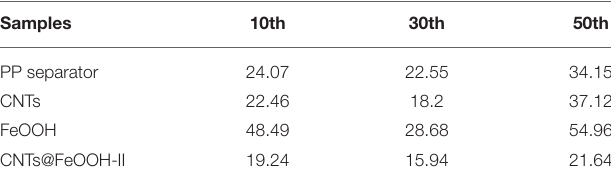
TABLE 2 | The comparison of Rct values of different interlayer and PP separator.